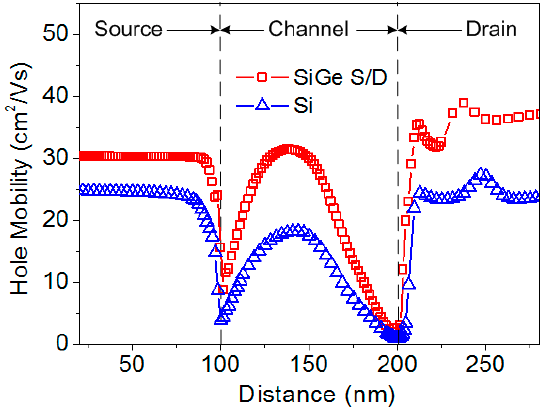
Figure 7. Hole mobilities at a distance of 5 nm below the Si/SiO 2 interface.